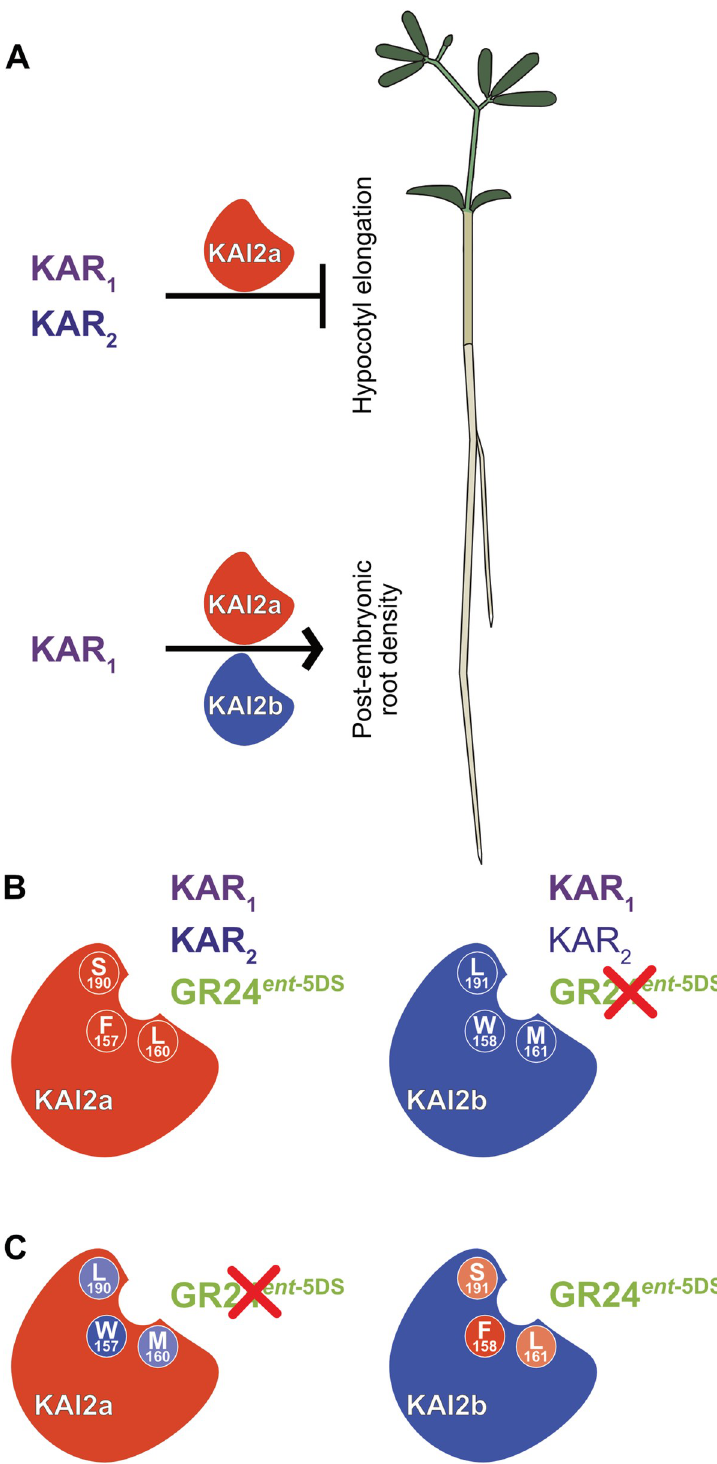
Fig 9. L . japonicus KAI2a and KAI2b display organ-specific redundancy and differ in their ligand-binding specificity. ( A ) Lj KAI2a is required to mediate inhibition of hypocotyl growth in response to KAR 1 and KAR 2 . In roots Lj KAI2a and Lj KAI2b redundantly promote postembryonic root density, but only in response to KAR 1 treatment. ( B ) In the Arabidopsis kai2-2 background Lj KAI2a mediates hypocotyl growth inhibition in response to KAR 1 , KAR 2 and GR24 ent -5DS . In the same background, Lj KAI2b mediates a stronger response to KAR 1 than to KAR